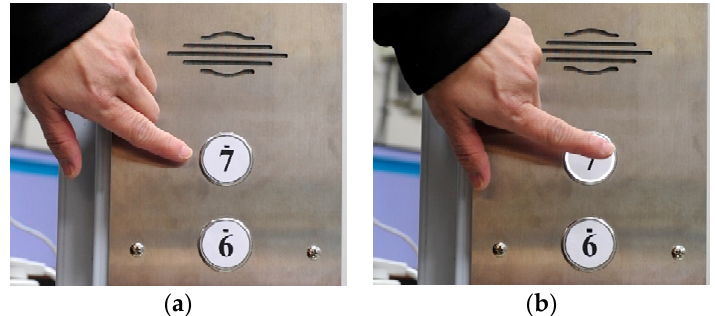
Figure 18. Activation and deactivation of contact-free perceptual buttons. ( a ) Finger not approaching the sensory button; ( b ) ginger close to sensory button.